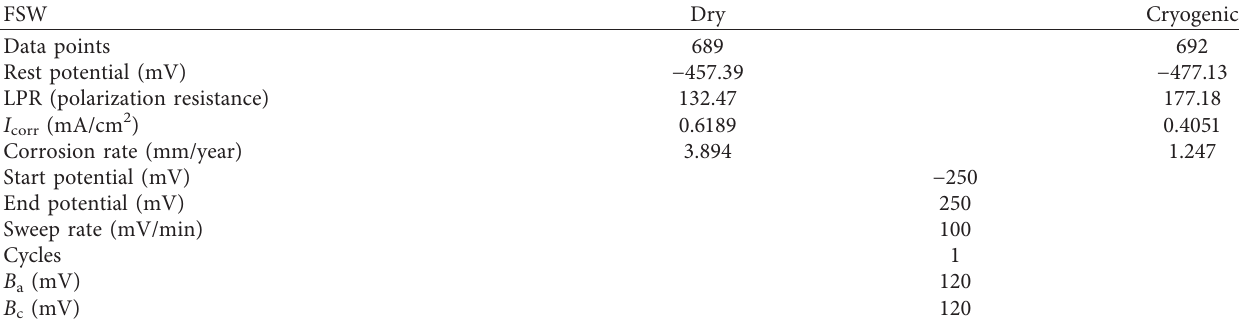
Table 14: Corrosion data recording for dry and cryogenic friction stir welding of AA 7075 aluminium alloys.